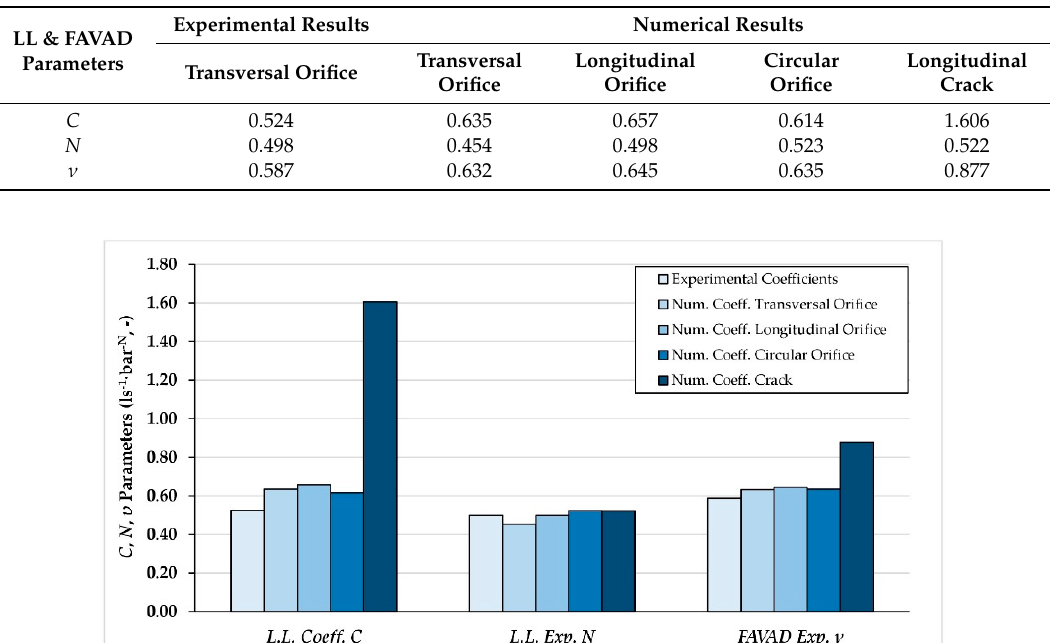
Table 8. Calibration of leakage law and FAVAD parameters with experimental and numerical analysis.